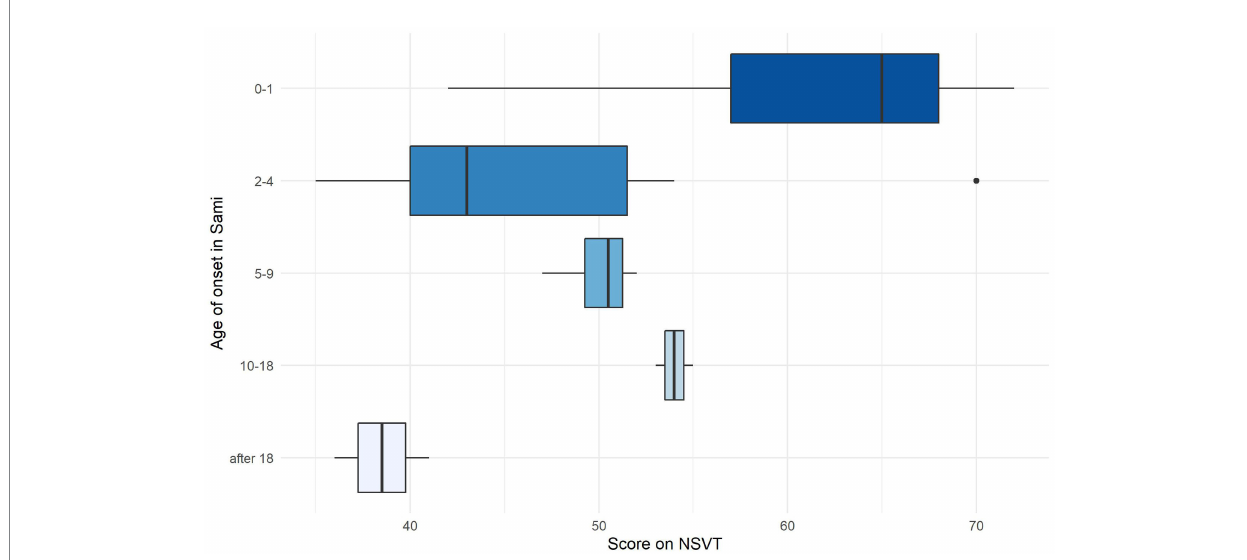
FIGURE 8 Result on NSVT for North Sámi participants (both countries) by age on onset in